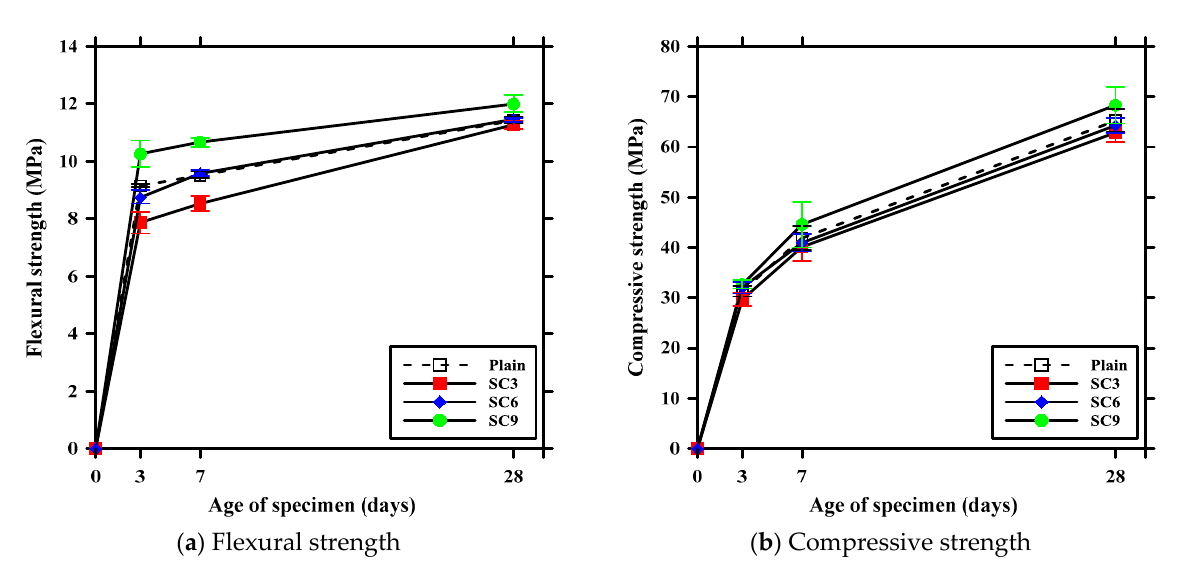
Figure 7. Strength of composites: ( a ) Flexural strength; ( b ) Compressive strength.